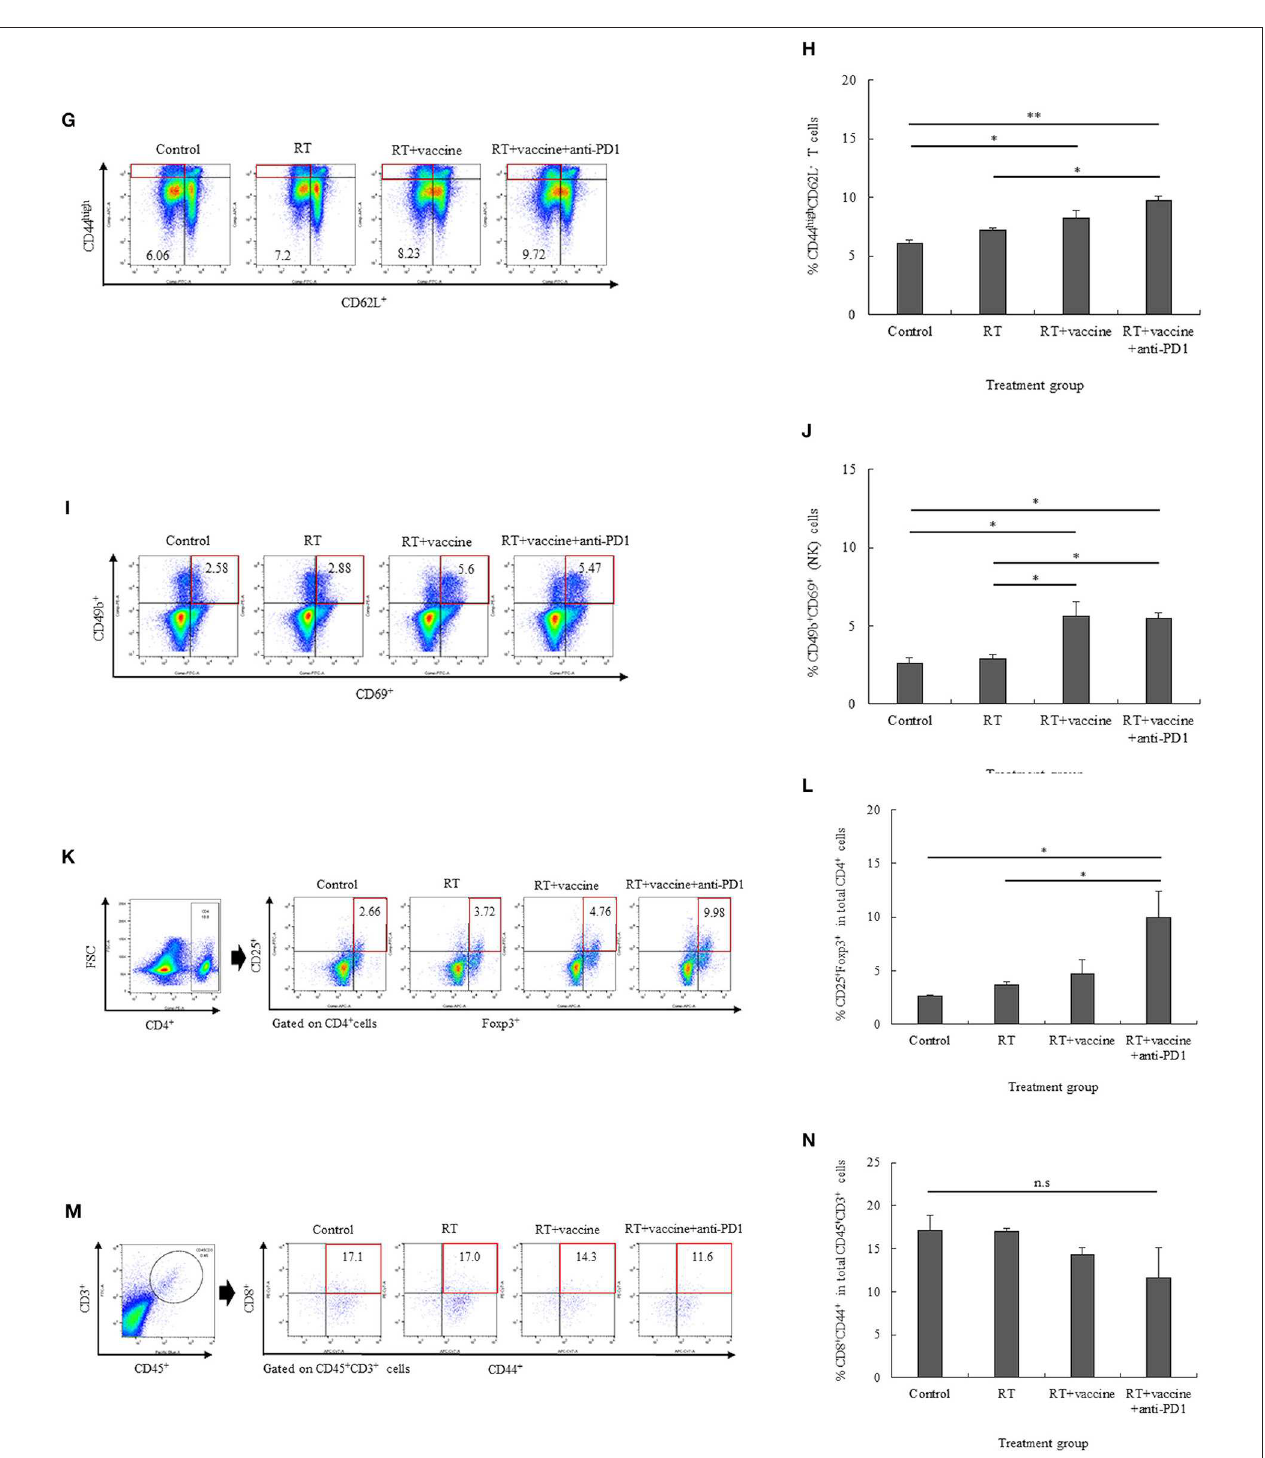
FIGURE 4 | The distribution of immune cells in the spleen and tumor was confirmed by flow cytometry. The presentation of activated CD8 + CD44 + T cells and high activated CD8 + CD44 high effector T cells (A–C) , activated CD4 + CD44 + T cells and high activated CD4 + CD44 high effector T cells (D–F) , high activated CD44 high CD62L − effector memory T cells (G,H), CD49b + CD69 + natural killer (NK) effector cells (I,J) , and CD4 + CD25 + Foxp3 + regulatory T cells (K,L) in the splenocytes of non-vaccinated and vaccinated mice was estimated. Moreover, the presentation of activated CD8 + CD44 + T cells in the tumor was also confirmed (M,N) . Data are summarized by bar charts as the mean ± standard deviation (SD). All data are represented as the mean of two independent experiments. Control, no treatment group; RT, radiation therapy; vaccine, branched multipeptide plus PADRE and poly-ICLC; * p < 0.05; ** p < 0.01; and *** p < 0.001; n.s., no significant difference.